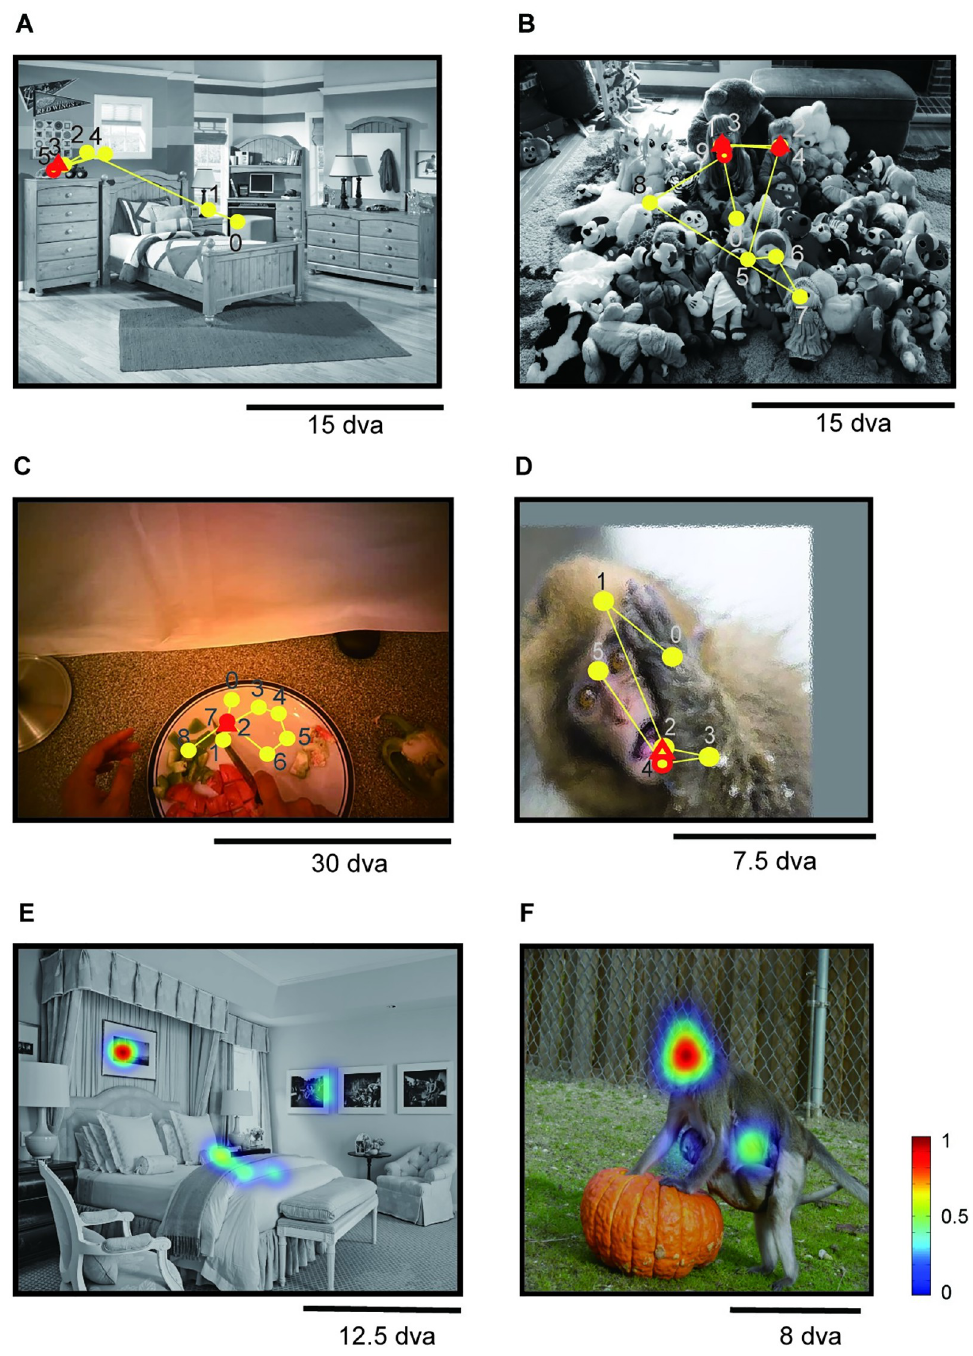
Fig 1. Primates make return fixations during natural vision. Example fixation sequences (yellow circles) of humans ( A-C ) and monkeys ( D ) during visual search ( A ), free viewing of static images ( B, D ), and a cooking task with a head- mounted eye tracker ( C ) (see Fig 2 for task definitions). The numbers denote the fixation order. A fixation (yellow circles) is referred to as a “return fixation” (red triangle) if the Euclidean distance to any of the previous fixations is less than 1 degree of visual angle (dva). The previous fixation overlapping with the return fixation is referred to as a “to-be-revisited” fixation (red circle). There are two return fixations in B and one in A, C , and D . E-F Return fixations are consistent across subjects. E and F show example images of consistent return fixations across subjects in free viewing tasks. Color bar on the right shows the scales of between- subject consistency (see S5 Fig for more examples). Photo sources: (A, B, E) were modified from a public dataset [8]. (C) was modified from a public dataset [48]. (D, F) Reproduced with permission from BPRC and pexels.com.